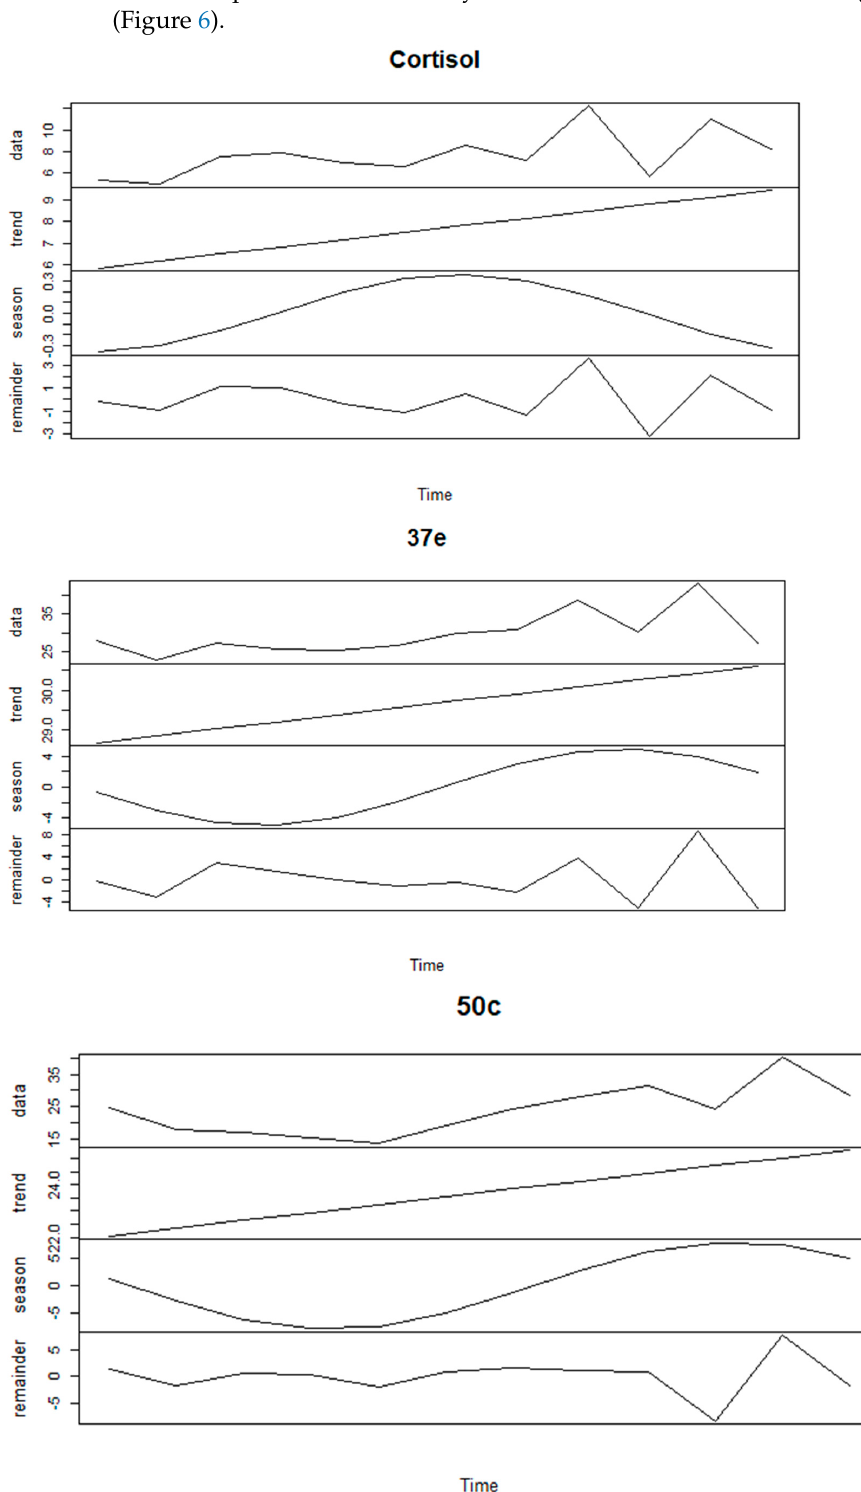
Figure 6. Time series for FCM (faecal cortisol metabolite) values measured with the cortisol, 37e (5 α -pregnane-3 β ,11 β ,21-triol-20-one) and 50c (tetrahydrocorticosterone) EIAs (enzyme immunoassays) over a 12-month period.